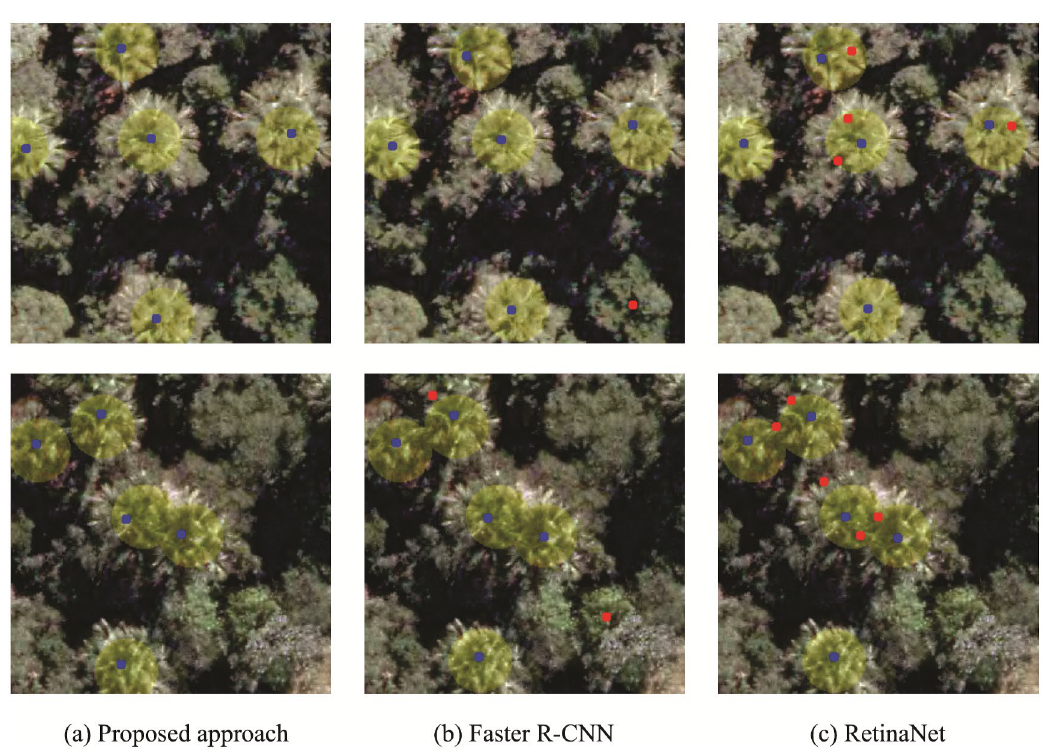
Figure 3. Visual comparison of the analyzed methods. ( a ) shows the detections obtained by the proposed approach; ( b ) indicates the detections of the Faster R-CNN and; ( c ) demonstrates the detections of the RetinaNet. Blue and red points correspond to correct and incorrect detection positions, respectively, and the yellow circle to M. flexuosa palms-trees